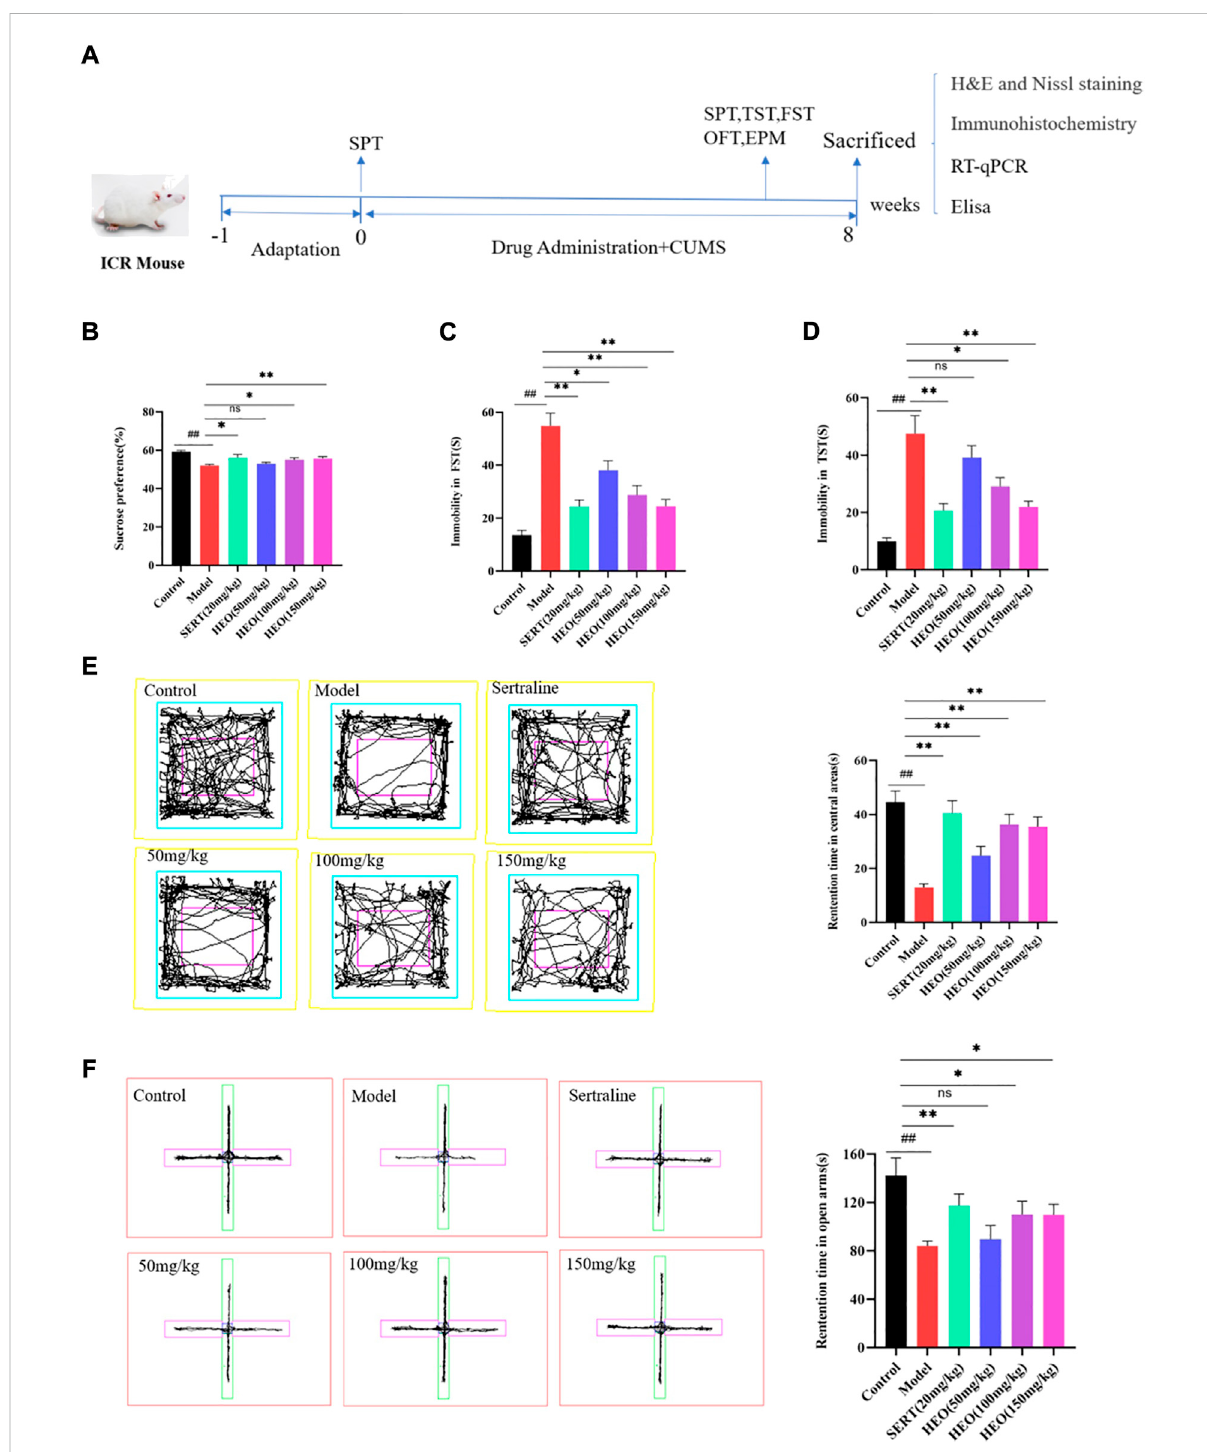
FIGURE 3 The Effect of HEO on depressive-like behavior treated by CUMS. The experimental schematic diagram (A) ; Sucrose preference test (B) ; Forced swimming test (C) ; Tail suspension test (D) ; Open fi eld test (E) ; The elevated plus-maze (Note:The rose red one represent open-arms and the green onerepresentclose-arms) (F) .Datawereexpressedasmean±SEM( n =8). ## p < 0.01vscontrolgroup;* p < 0.05,** p < 0.01vstheCUMSgroup.HEO, the essential oil from the fruits of Z. bungeanum Maxim.; SERT, Sertraline; CUMS, chronic unpredictable mild